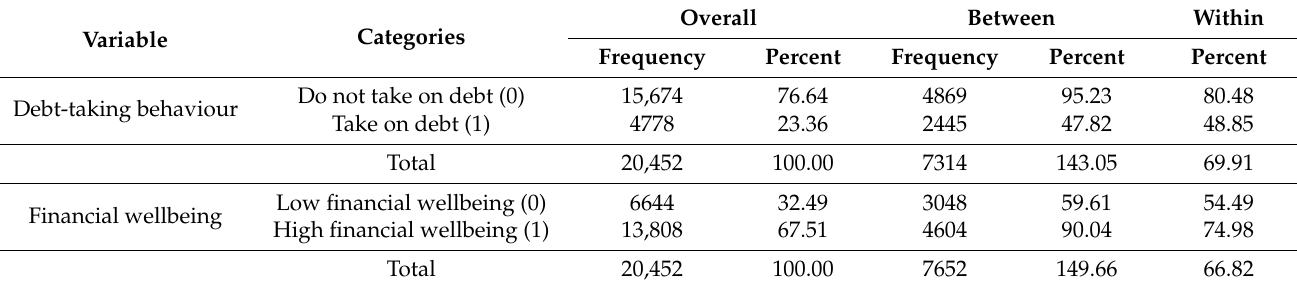
Table 4. Within and between components of debt-taking behaviour and financial wellbeing. Variable